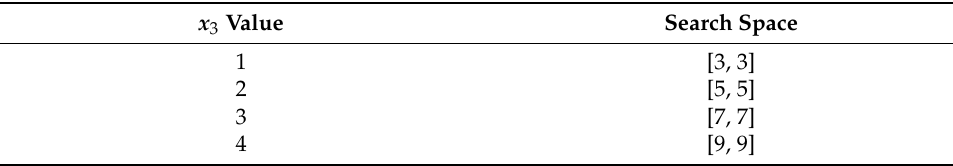
Table 2. Convolutional filter dimensions for the x 3 position.